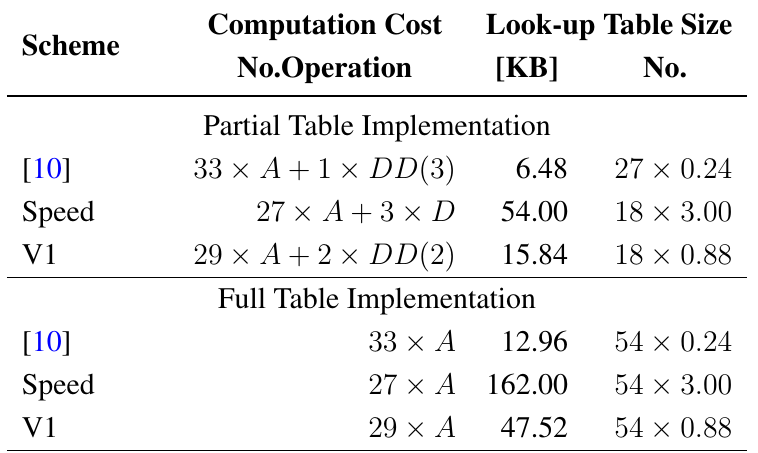
Table 7. Evaluation result of fixed-base scalar multiplication, where A , D and DD ( w ) denote addition, doubling and direct doubling (width),